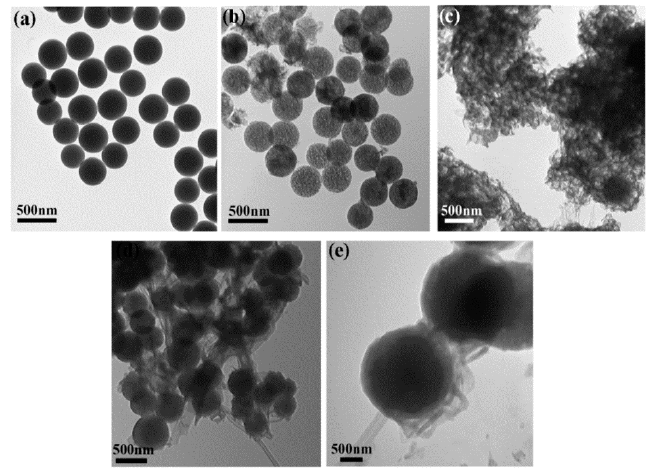
Figure 4. TEM images of ( a ) SiO 2 , ( b ) porous silicon sphere (Si), ( c ) PProDOT(MeSH) 2 , ( d ) and ( e ) PProDOT(MeSH) 2 @Si.